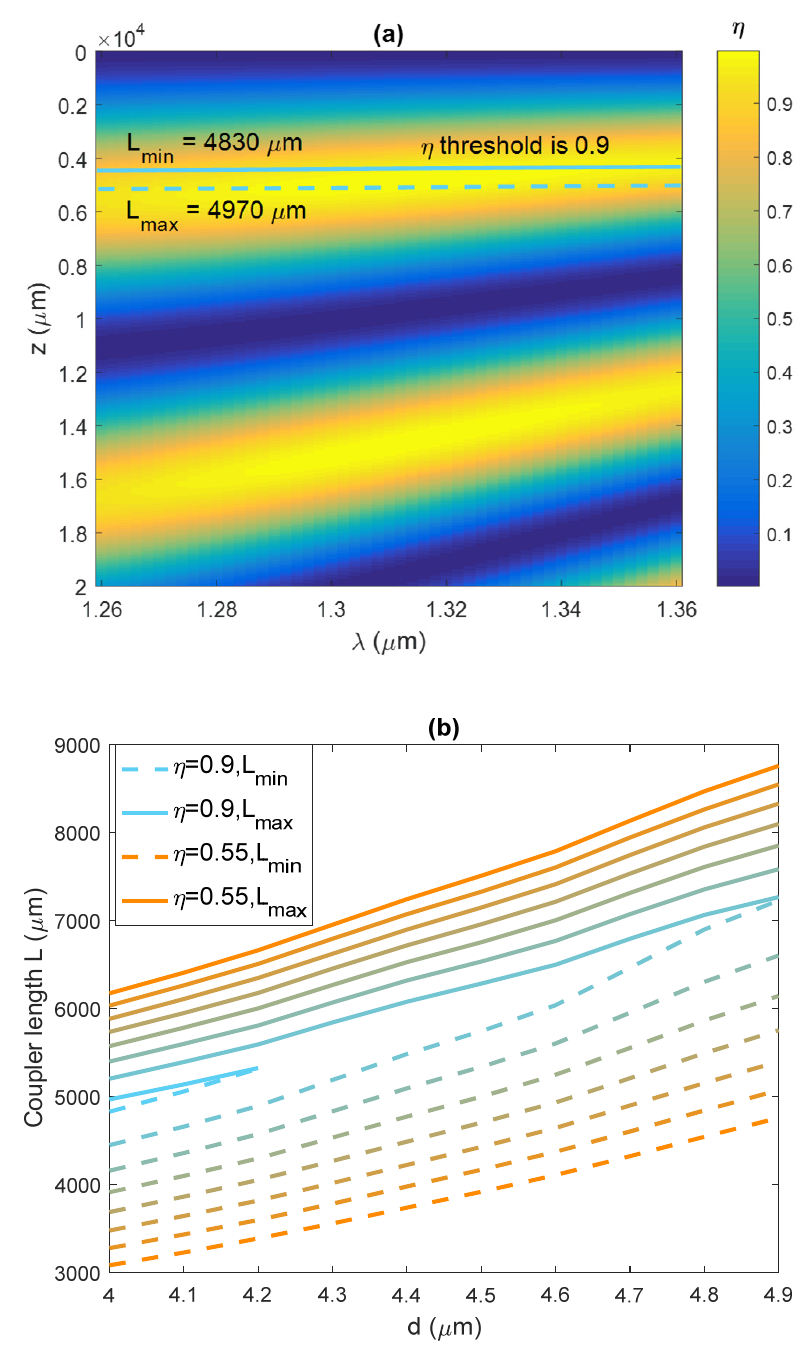
Figure 5. ( a ): Color map of the coupling ratio η as a function of coupler length and wavelength. Two lines represent the allowed coupler length range to achieve the broadband coupling ratio 0.9; ( b ) Allowed coupler length range for chosen coupling ratio threshold, varying from 0.9 to 0.55 with an interval of